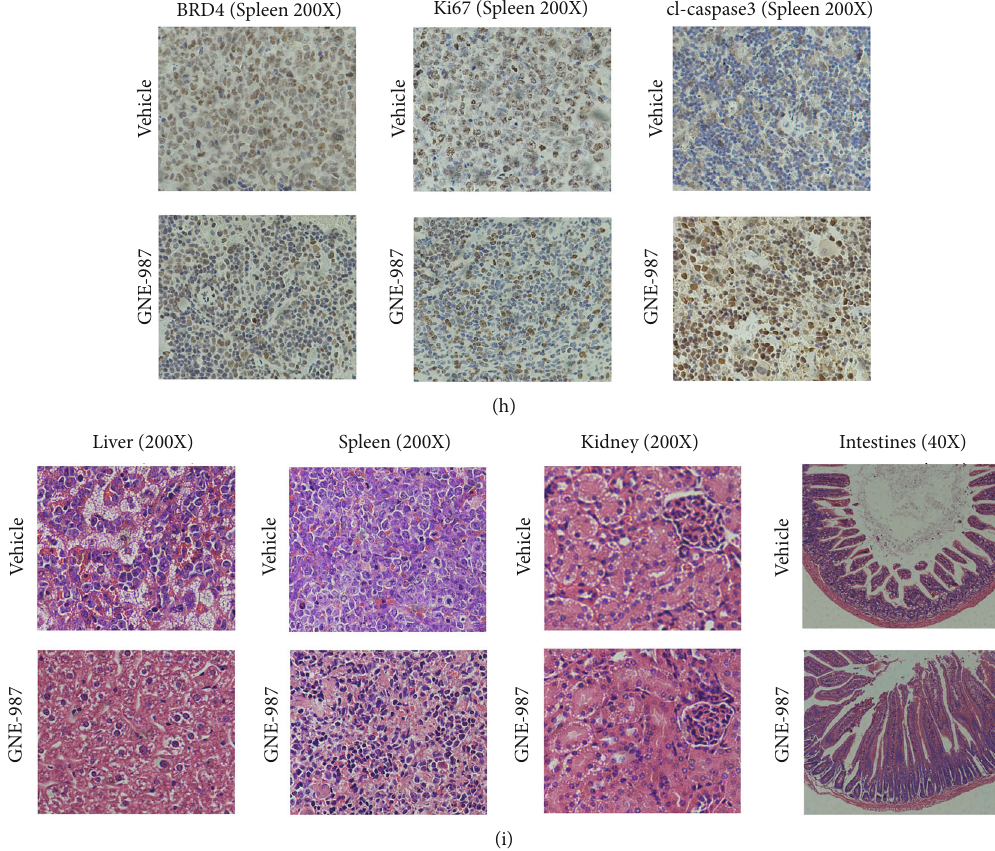
Figure 7: In vivo studies con fi rm that GNE-987 has a powerful antitumor e ff ect. (a) Schematic diagram of the in vivo experiment. (b) On days 2, 4, 7, and 10, we used the NightOWL In Vivo Imaging System to image each group of mice. (c) The comparison of the fl uorescence statistics of the two groups of mice shows that GNE-987 can signi fi cantly reduce liver and spleen in fi ltration in mice. (d) GNE-987 can extend the survival time of mice. (e) The body weights of the two groups were not signi fi cantly di ff erent. (f) Photographs of the liver and spleen of two groups of mice. (g) Liver and spleen weight from GNE-987- or vehicle-treated mice. (h) IHC staining of BRD4, Ki67, and cleaved-caspase 3 in AML xenograft models from GNE-987- or vehicle-treated mice. (i) HE-stained sections of the liver, spleen, kidney, and intestine from GNE-987- or vehicle-treated